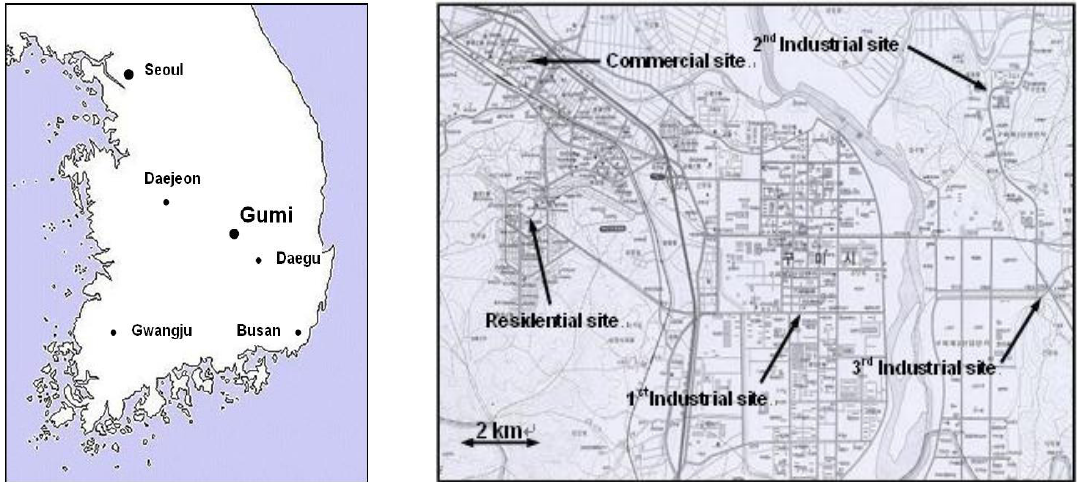
Figure 1. Locations of Gumi city and five sampling sites in the